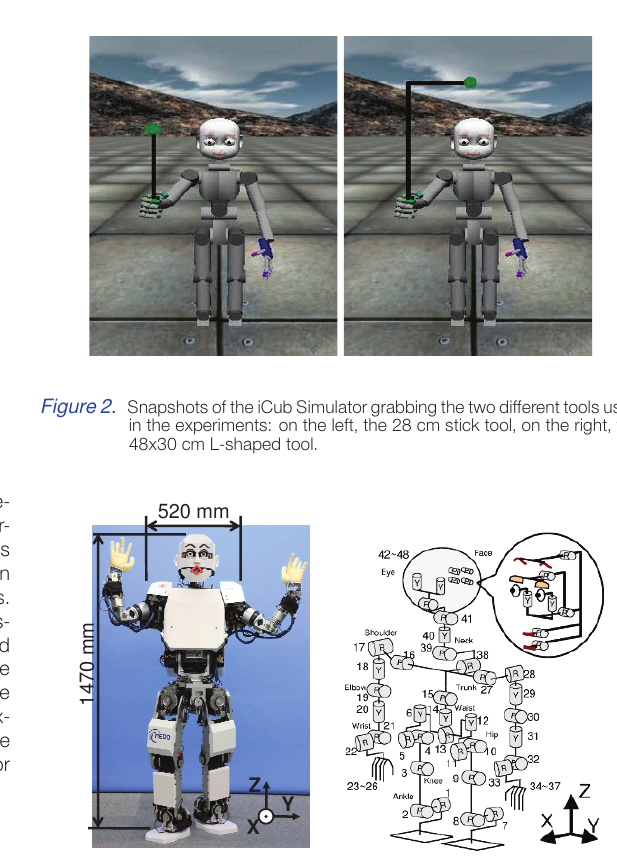
Figure 3. Kobian humanoid robot. On the left, Kobian expressing surprise. On the right, description of the robot 48 DOFs.